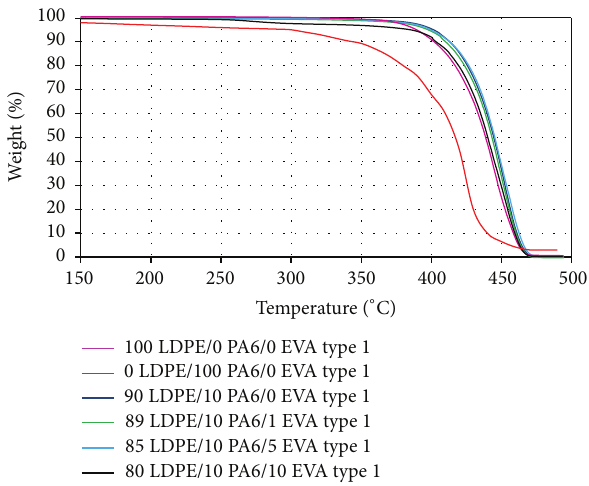
Figure 4: TGA curves of polymer composites LDPE/PA 6/EVA type 1 (wt.%).